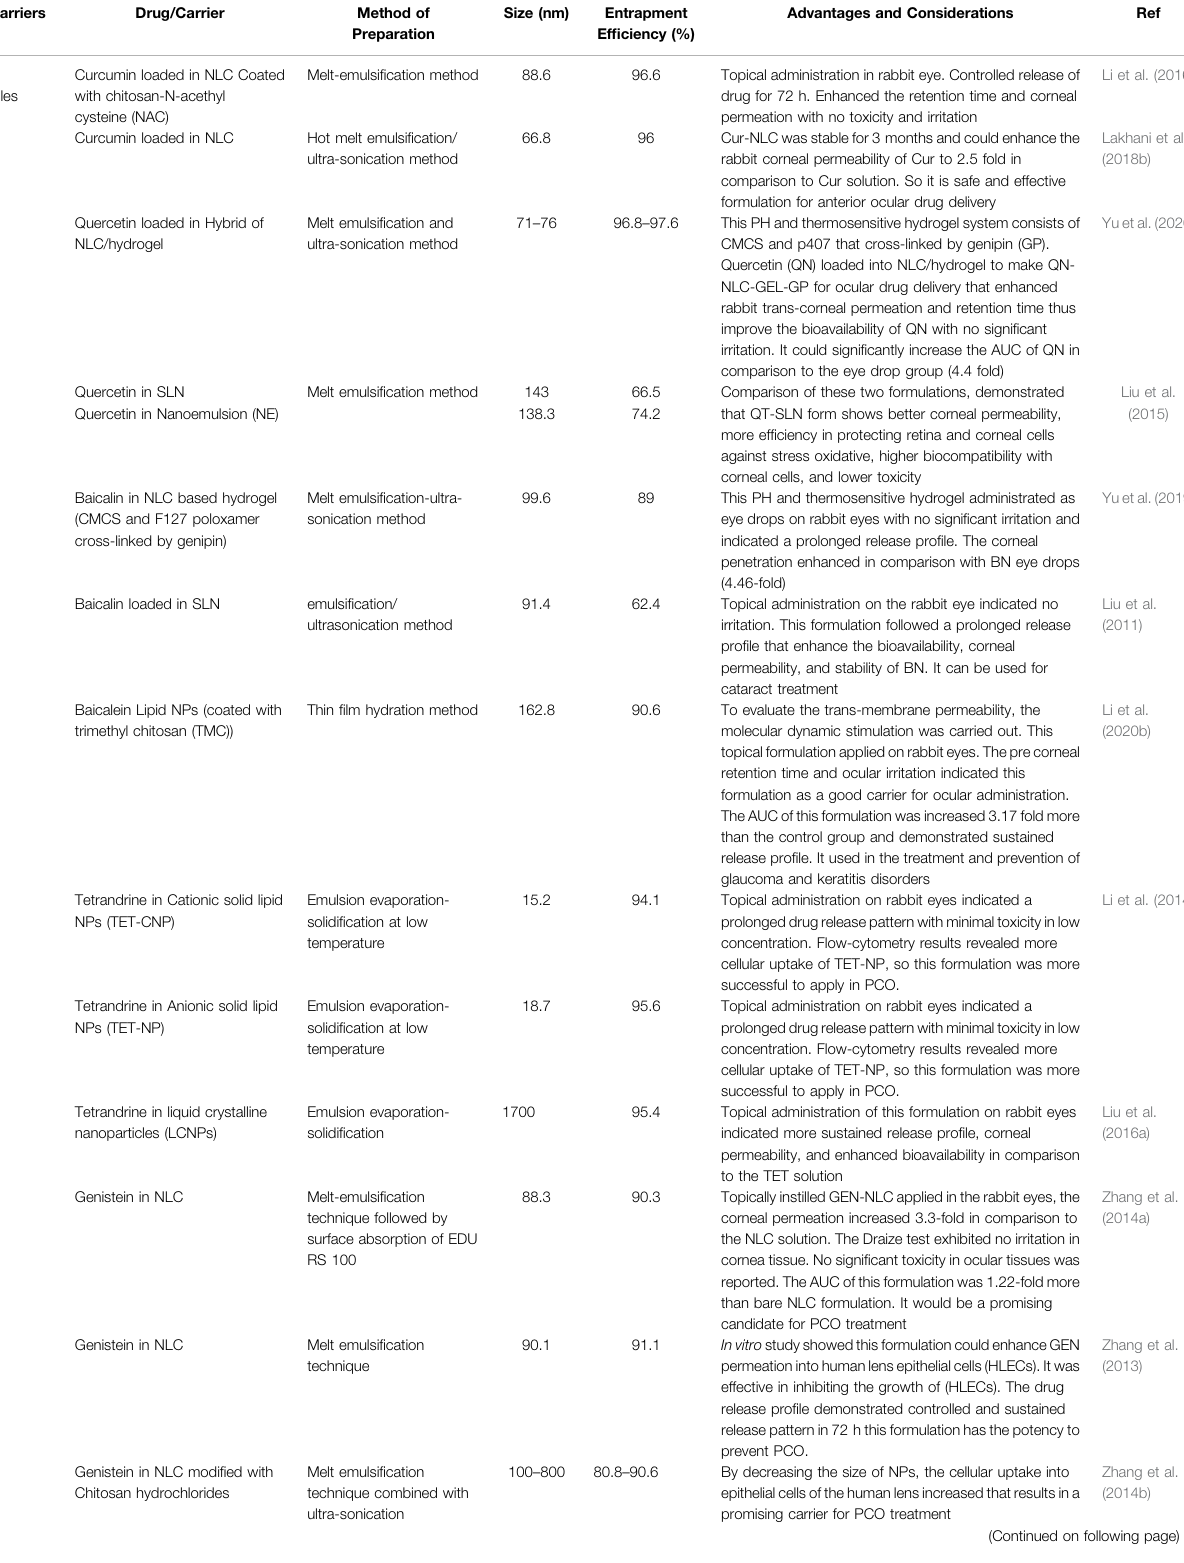
TABLE 3 | Natural based nanoparticles used in ocular drug